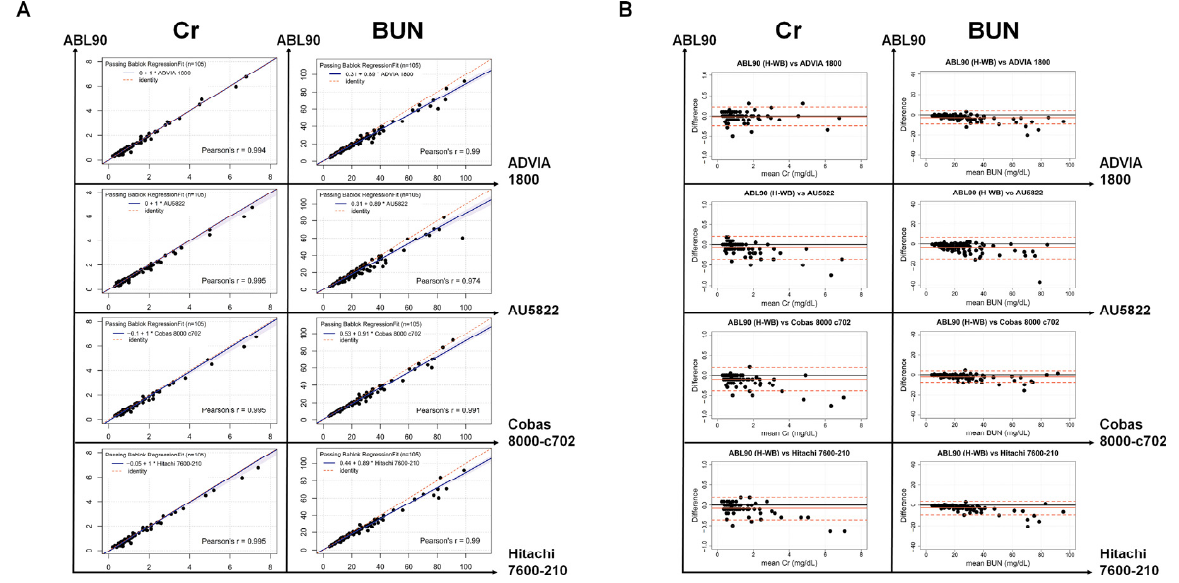
Figure 1. Passing–Bablok regression ( A ) and Bland–Altman plot ( B ) of Cr and BUN testing using the ABL90 FLEX PLUS and H-WB compared with the four other automated chemistry analyzers. ( A ) The blue-colored area represents the 95% CI of the regression line. ( B ) The black and orange solid lines indicate the zero and mean differences, respectively. The dashed orange line represents the two SDs of the mean difference. Cr: creatinine; BUN: blood urea nitrogen; H-WB: heparinized whole blood.